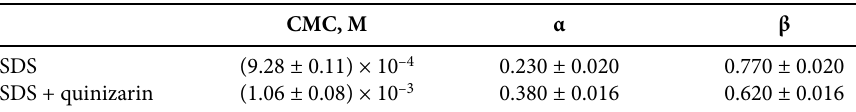
Table 2. Critical micelle concentration (CMC), degree of ionization (α) and degree of counterion bind- ing (β) for SDS in 0.1 M phosphate buffer (pH 7.4) and in the presence of 2.15 × 10 –5 M quinizarin at 293.15 K. CMC, M